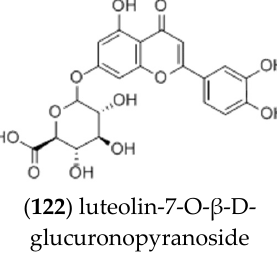
Figure 9. Structures of flavonoids isolated from ST . Table 2. The contents of eight components in ST from 13 different origins in China (mg/g) [21].